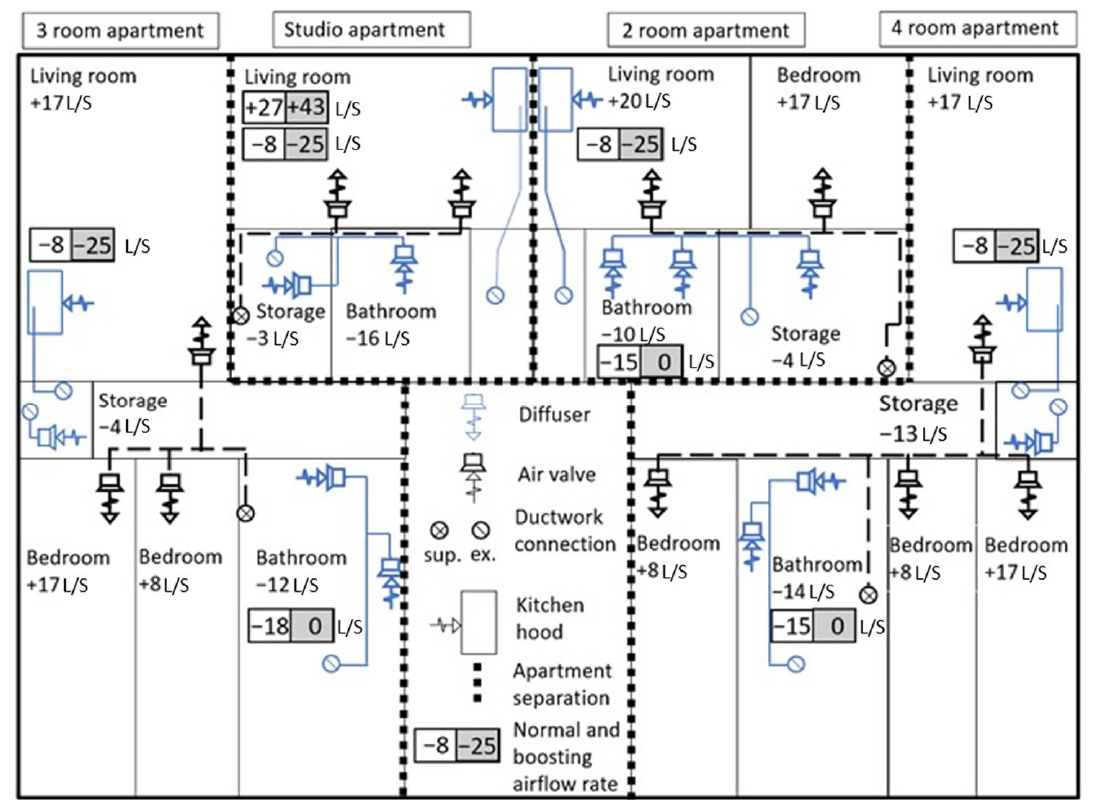
Figure 2. Airflow rate of rooms in differently sized apartments on one floor during normal and boosting